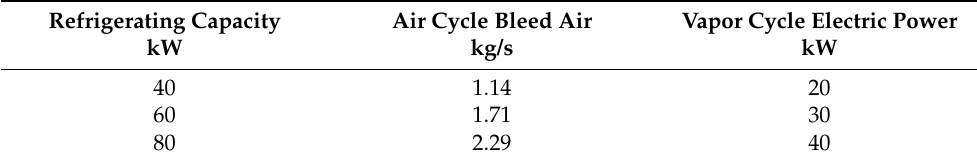
Table 4. Extracted energy required under different heat load